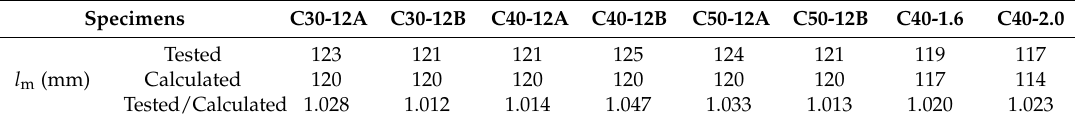
Table 8. The calculated and tested values of the average crack spacing ( l m ) of the test